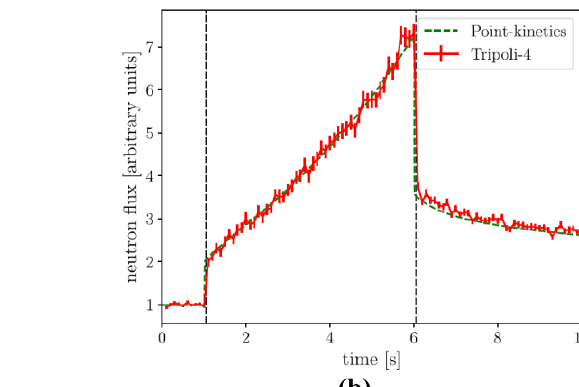
Figure 5: Cross section of SPERT III E core (a) and the neutron flux increase after the control rod movement starting from a critical core at zero sec (b). Control rods are extracted at one sec and are inserted back at six sec